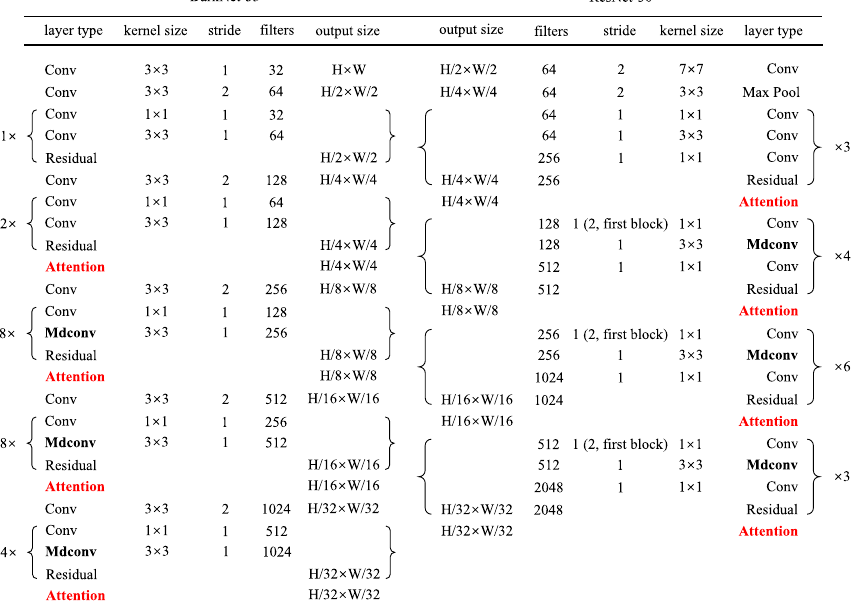
Fig. 3 The hierarchical structures of the improved DarkNet-53 and improved